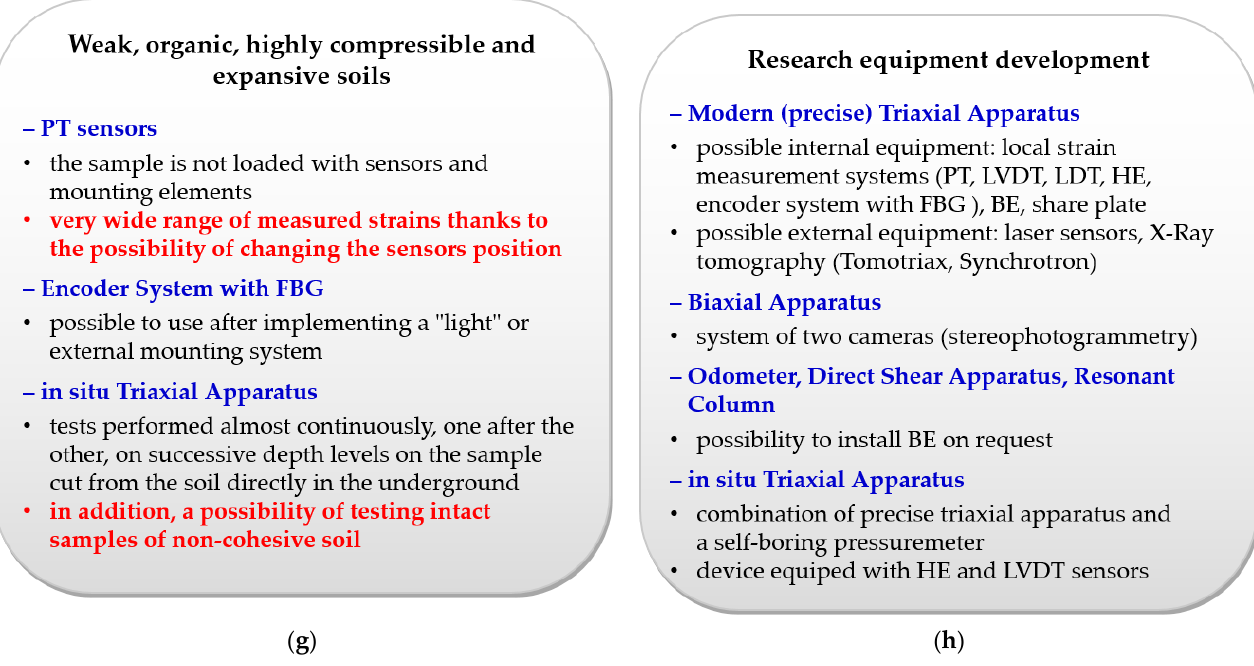
Figure 22. Guidelines for selecting the appropriate deformation measurement systems depending on: ( a ) Commercial internal measuring systems; ( b ) Systems used individually, not widespread; ( c ) Non-commercial measuring systems; ( d ) Systems under implementation; ( e ) Measured values (or indirectly parameters); ( f ) Mounting method; ( g ) Weak, organic, highly compressible, and expansive soils; ( h ) Research equipment development. (PT–Proximity Transducers, LVDT–linear variable differential transformer, LDT–local deformation transducer, HE–Hall effect gage, BE Bender elements, FBG–fiber Bragg grating).